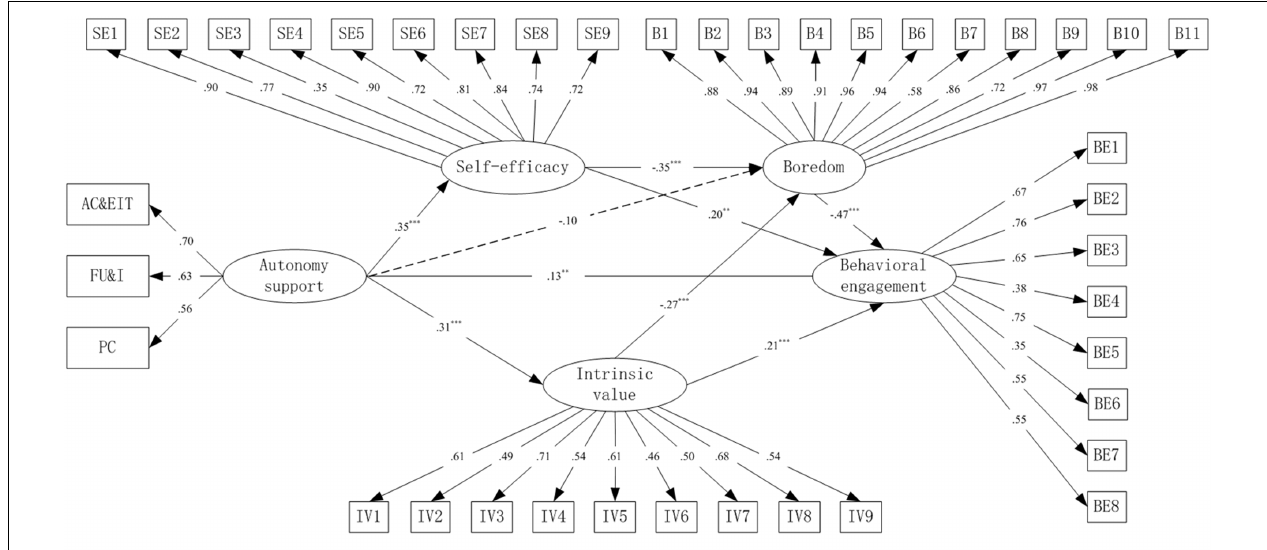
FIGURE 2 | Full mediation model for behavioral engagement as dependent variable. PC, providing choice; FU&I, fostering understanding and interest; AC&EIT, allowing criticism and encouraging independent thinking; SEl–SE9, nine items of self-efficacy; IV1–IV9, nine items of intrinsic value; B1–B11, 11 items of boredom; BE1–BE8, eight items of behavioral engagement. ∗∗∗ p < 0.001; ∗∗ p <